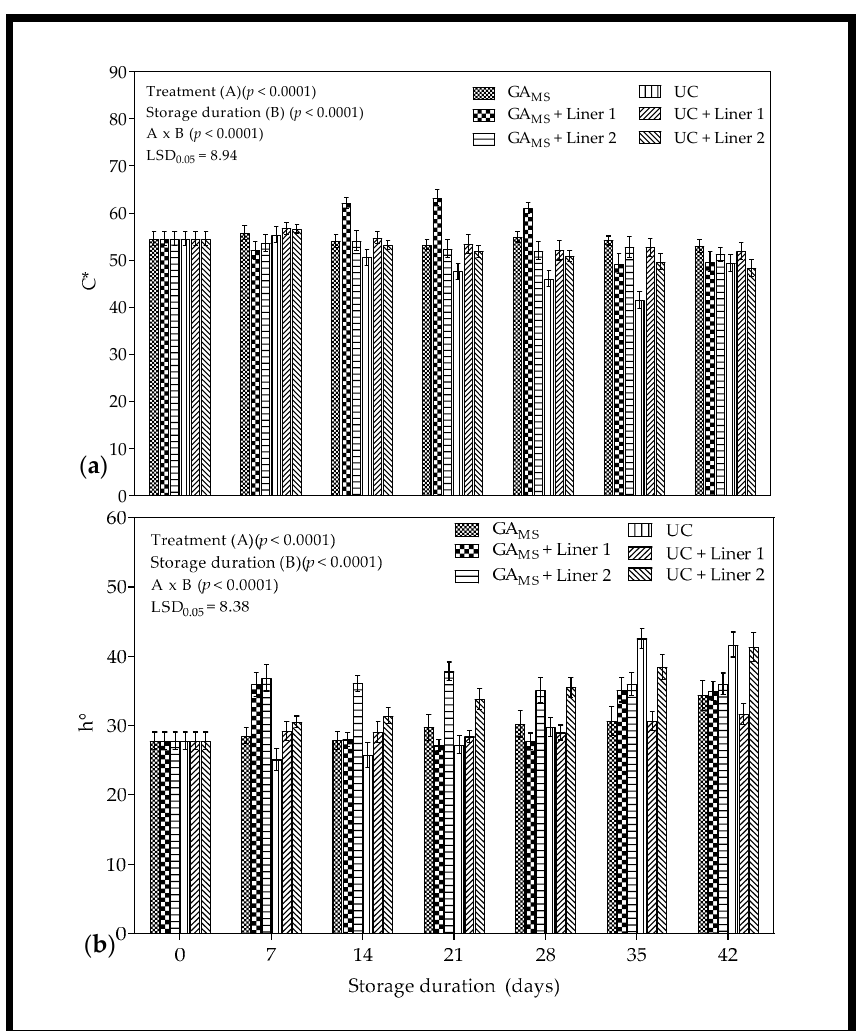
Figure 6. Color attributes ( a ) chroma (C*) and ( b ) hue angle (h°) of ‘Wonderful’ pomegranate coated and packaged in different polyliners and stored (5 ± 1 °C, 95 ± 2% RH) for 42 d. GA MS —gum Arabic (0.5% w / v ) and maize starch (0.5% w / v ); Liner 1—Xtend ® liner (20µmm perforations); Liner 2—perforated liner (4 mm perforations); UC—uncoated fruit. LSD 0.05 represents least significant difference ( p < 0.05).